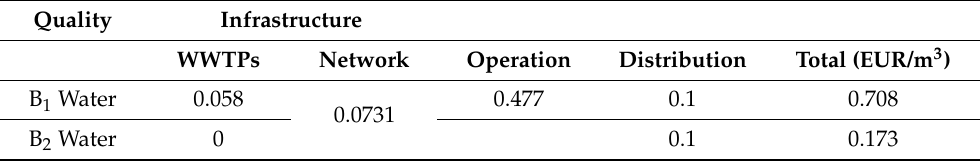
Table 6. Amortization and operating costs (EUR/m 3